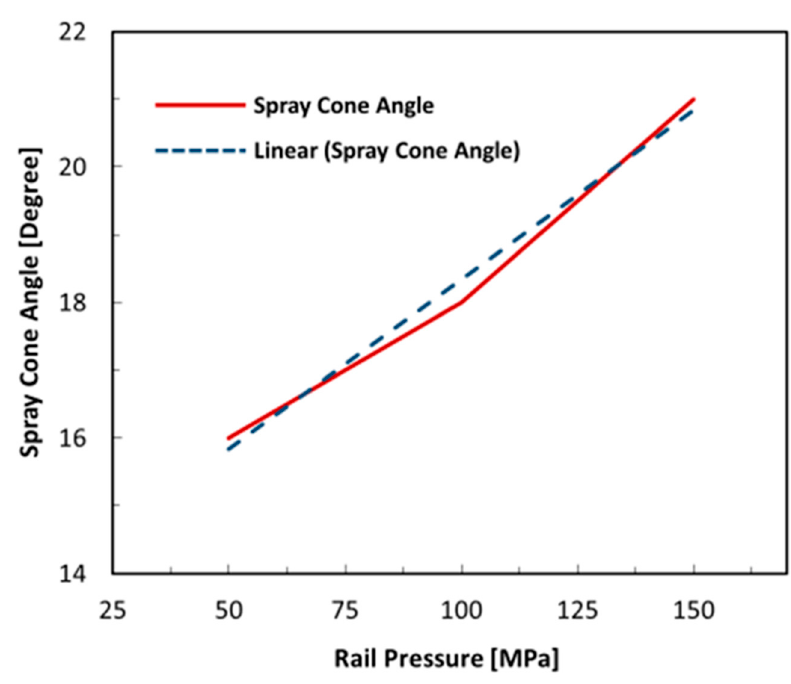
Figure 13. Comparison spray cone angle for different rail pressures.